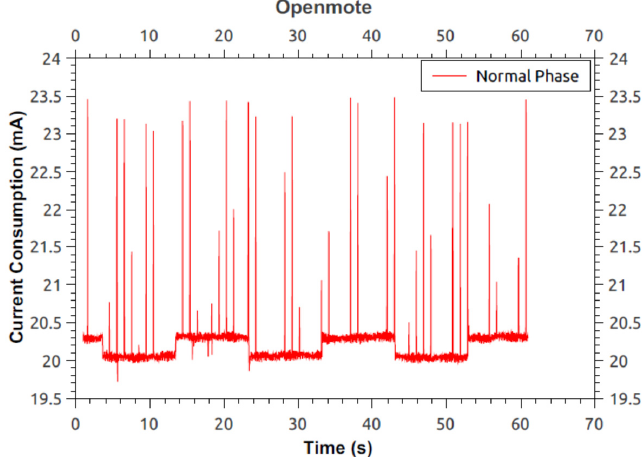
Figure 18. Current consumption of OpenMote running modified protocol during normal phase.